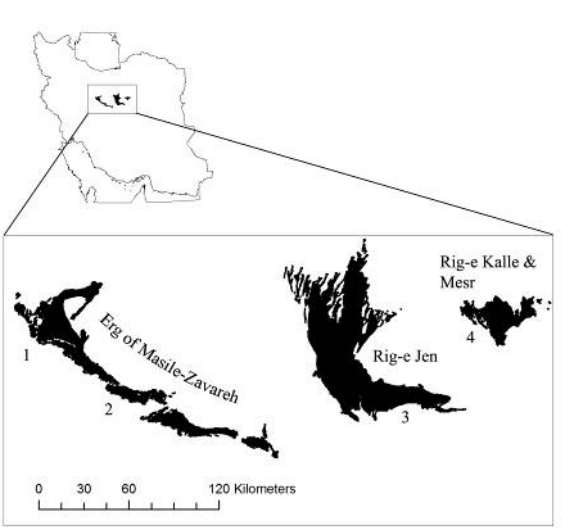
F IGURE 1.- The shape and location of the ergs (Mahmoodi, 2002) in central Iran and species collected: 1) Chartaghi: E. aelleni 2) Aboozeidabad: E. aelleni 3) Hojatabad: E. pfaundleri 4) Mesr: E. pfaundleri